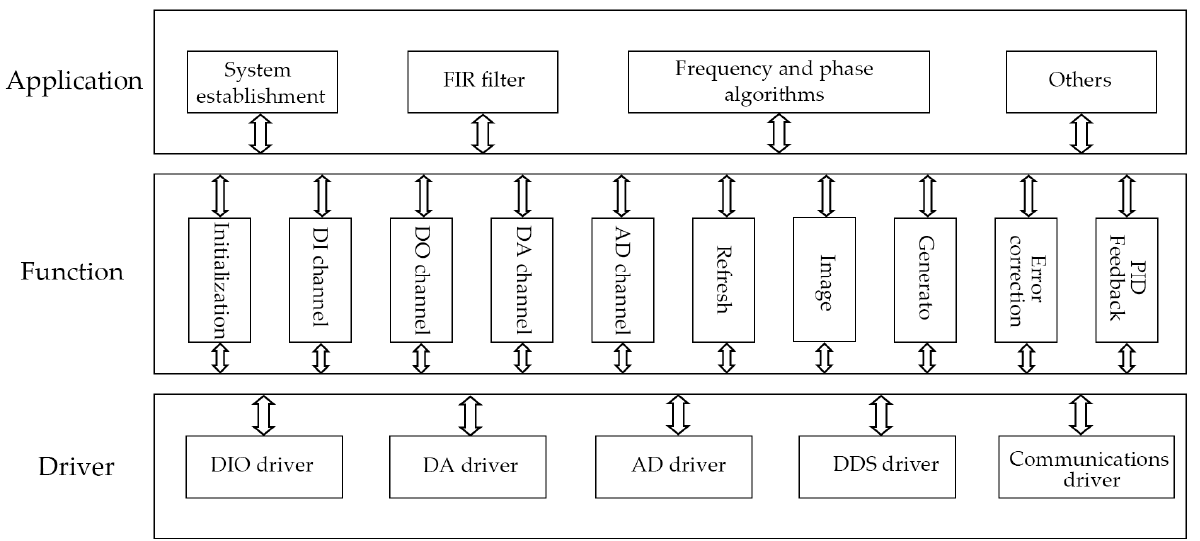
Figure 10. Schematic diagram of the embedded control software structure.